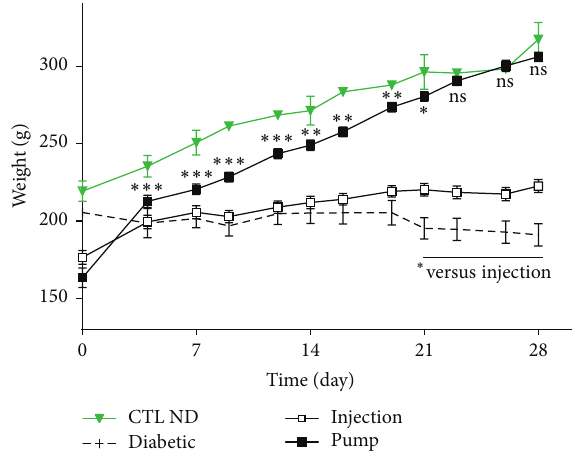
Figure 4: Weight of rats. The control nondiabetic (CTL ND) rats had a normal and regular weight gain curve. Rats of the pump group succeeded in reaching the control level within 21 days. Rats from the diabetic and injection groups did not gain much weight during the study period. Injection group is different from CTL ND and pump groups at all time points since day 7 ( 𝑝 < 0.01 ). Injection group is also different from diabetic group since day 21 ( 𝑝 < 0.05 ).